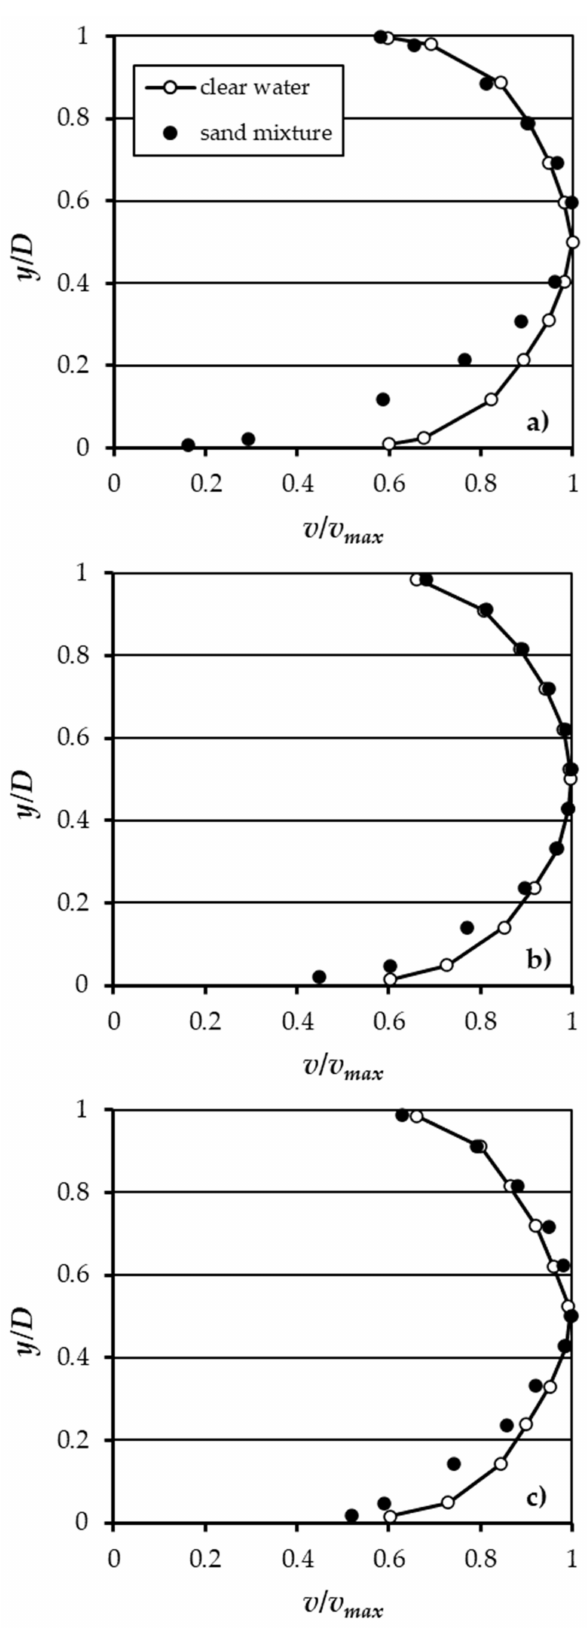
Figure 2. Velocity profile measurements for given hydraulic conditions (clear water and sand concentration of 0.054) and the three investigated sand mixtures ( D m = 0.88 mm ( a ), 0.41 mm ( b ) and 0.30 mm ( c